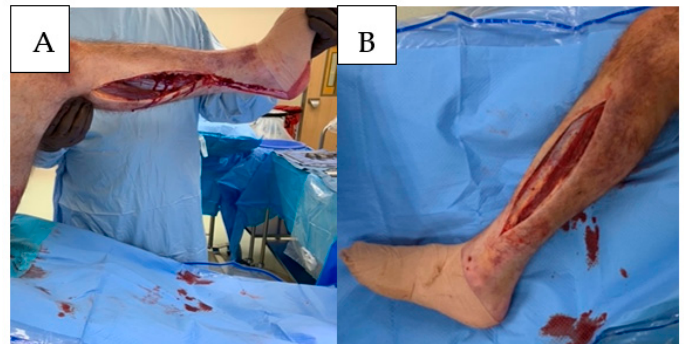
Figure 4. Four compartment fasciotomies performed with a medial ( A ) and lateral ( B ) fasciotomy incisions.